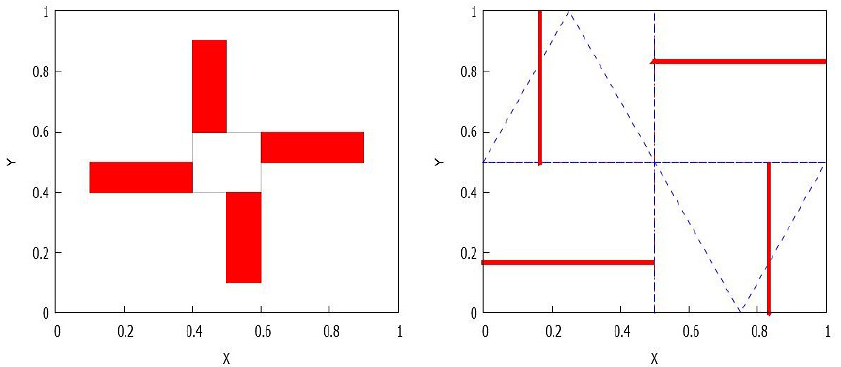
Figure 36. Here, the projections of ω F ( x , y ) are connected but ω F ( x , y ) is